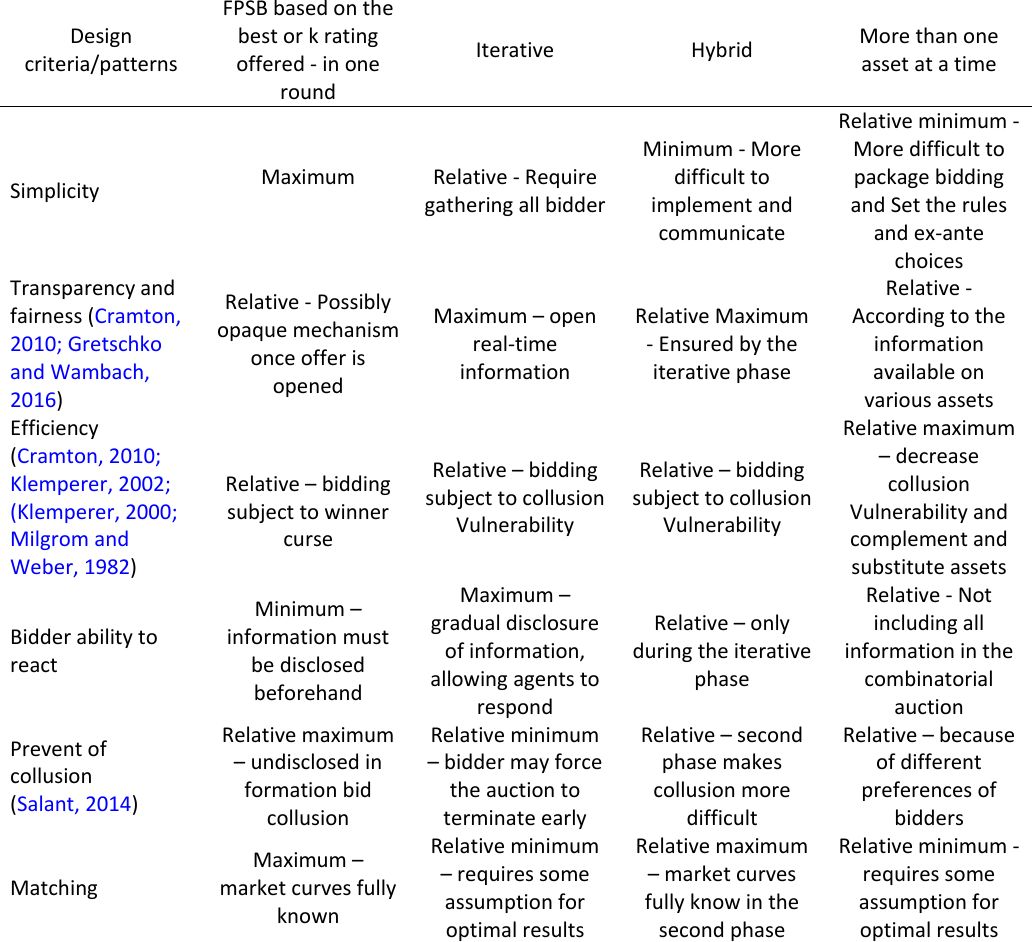
Table 1. Characteristics of chosen models to allocate the exploitation rights of assets Table 1 : Characteristics of chosen models to allocate the exploitation rights of